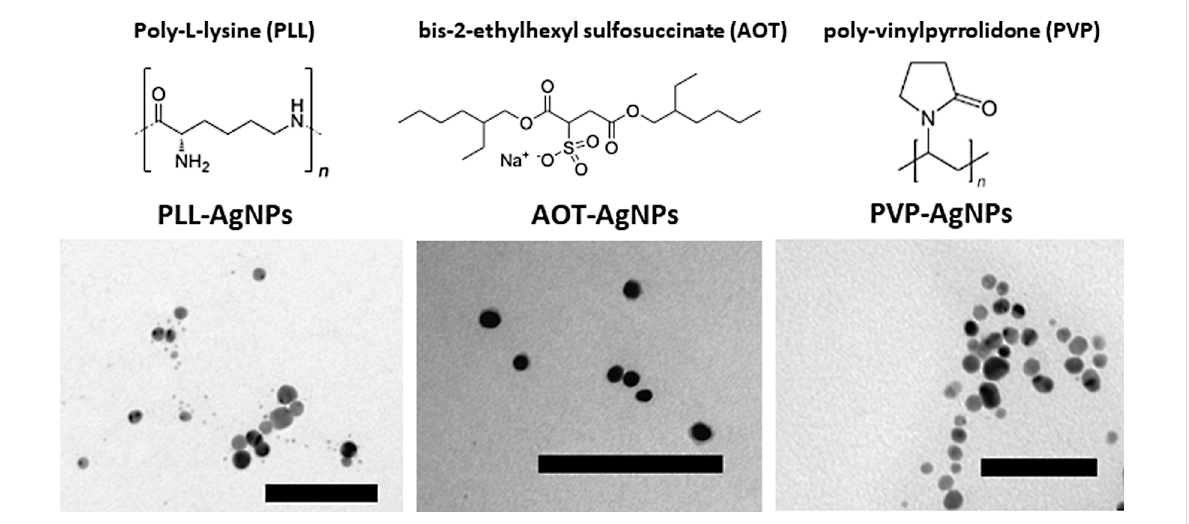
Figure 1: TEM images of freshly synthesized silver nanoparticles (AgNPs) coated with PLL, AOT, or PVP dispersed in ultrapure water at a concentra- tion of 10 mg Ag/L. Scale bars are 100 nm.